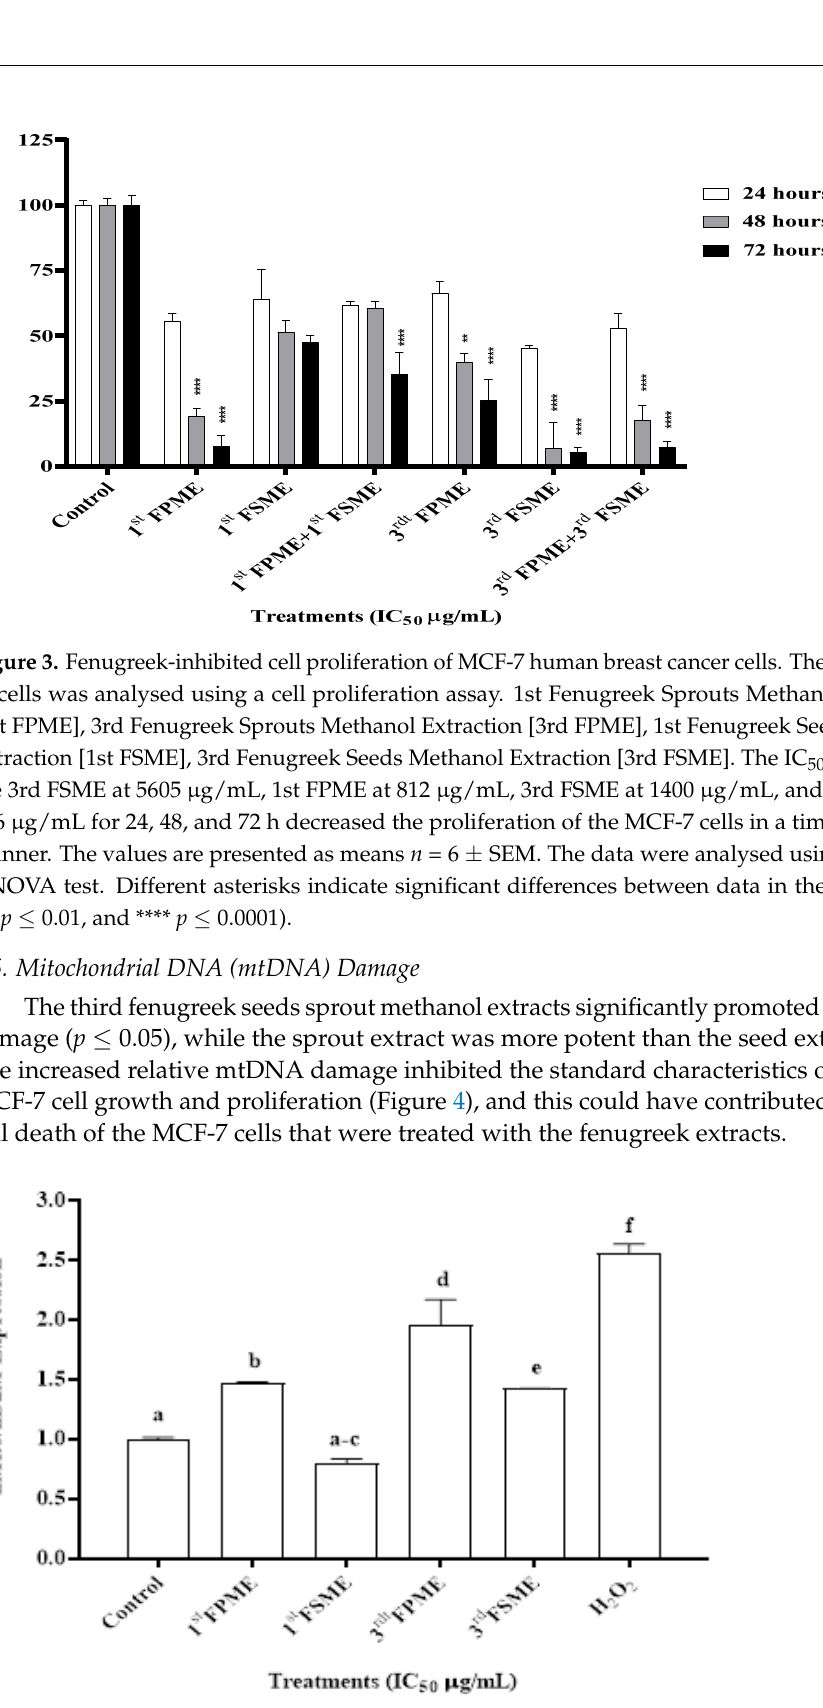
Figure 4. The mtDNA relative content in the MCF-7 cells. Amplified by RT-PCR and normalised to the human Beta-2 microglobulin [hB2M] nuclear gene after IC 50 treatment of the 3 rd FSME at 5605 µg/mL, 1 st FPME at 812 µg/mL, 3 rd FSME at 1400 µg/mL, and 3 rd FPME at 526 µg/mL in the MCF-7 cells for 24 h; H 2 O 2 was used as a positive control. 1 st Fenugreek Sprouts Methanol Extraction [1 st FPME], 3 rd Fenugreek Sprouts Methanol Extraction [3 rd FPME], 1 st Fenugreek Seeds Methanol Ex- traction [1 st FSME], 3 rd Fenugreek Seeds Methanol Extraction [3 rd FSME], hydrogen peroxide [H 2 O 2 ] (Sigma H1009). The values are presented as means n = 4 ± SEM. The data were analysed using a two-way ANOVA test. The different letters on top of the bars indicate significant differences ( p ≤ 0.05) between the data. 4. Discussion Of the three extraction solvents used ( n -hexane, methanol, and chloroform), metha- nol was the most efficient at obtaining the highest extraction yields from the fenugreek sprouts and seeds. This was also demonstrated in a recent study in which bioactive phy- tochemicals were extracted from fenugreek seeds using a hydromethanolic solution (50/50, v/v ) [7]. LC-MS analysis revealed that flavonoids and their glycosides, particularly apigenin C -glycosides, were the main compounds detected in the fenugreek extracts. Lu- teolin C -glycosides were also detected but were less abundant. This was consistent with a recent study [12] in which apigenin and luteolin adducts were the most abundant flavo- noid glycosides in germinated fenugreek seed extracts. In an earlier study [7], the major constituents included non-acylated flavonoid glycosides (48%), acylated flavonoid glyco- sides (46%), and phenolic acids (6%), and the major flavonoid constituents included apig- enin (61%), luteolin (21%), and kaempferol (11%). These results were consistent with those of the current study, in which flavone derivatives were predominant in the fenugreek seed extracts. Herein, five different flavones or their glycosides (apigenin, vicenin-2, vitexin, luteo- lin and orientin) and two isoflavones (daidzein and formononetin) were quantified in the fenugreek extracts. Apigenin glycosides including vitexin and vicenin-1 and -2 were pre- viously quantified in fenugreek seeds [13]. Among the flavones or their glycosides de- tected, apigenin was more abundant in the FPMEs than in the FSMEs, while the yields of vicenin-2, luteolin, orientin, and vitexin were more abundant in the FSMEs than in the FPMEs. Among the isoflavones detected, daidzein was more abundant in the seeds, while formononetin was more abundant in the sprouts. Thus, consistent with the literature [13,14], the findings from the current study indicated that flavones are primarily present in fenugreek seeds, while isoflavones are more abundant in fenugreek sprouts. Herein, the FPMEs and FSMEs reduced cell viability in a dose- and time-dependent manner, consistent with two previous studies on seeds [15,16], and showed these effects